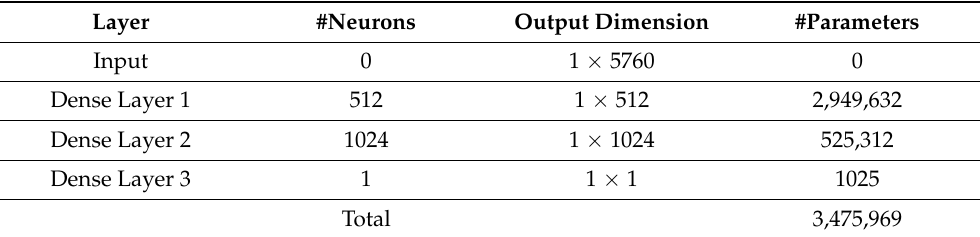
Table 3. Designing of the MLP-based feature transformation for the FS network. Layer #Neurons Output Dimension #Parameters